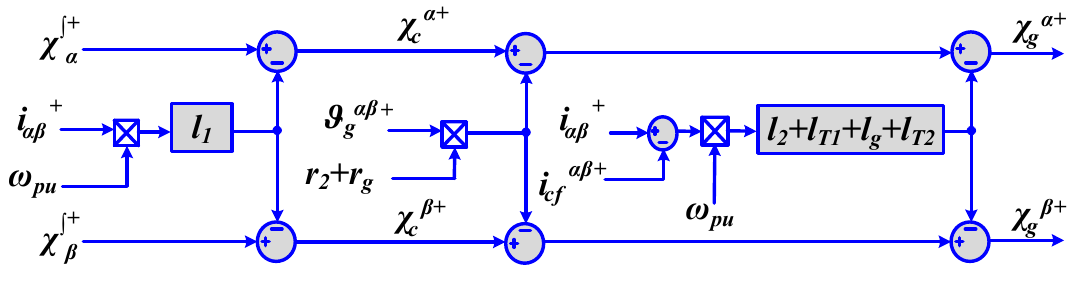
Figure 9. Virtual flux estimation at the grid side.